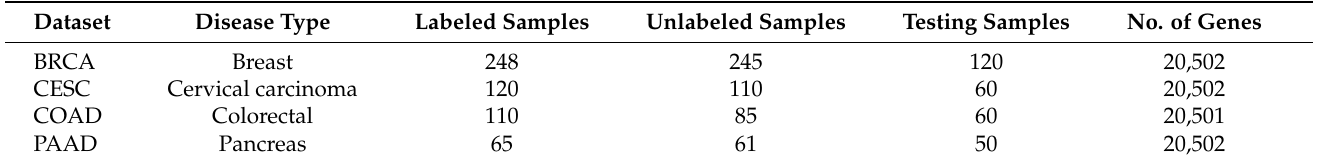
Table 2. Details of the experimental dataset.